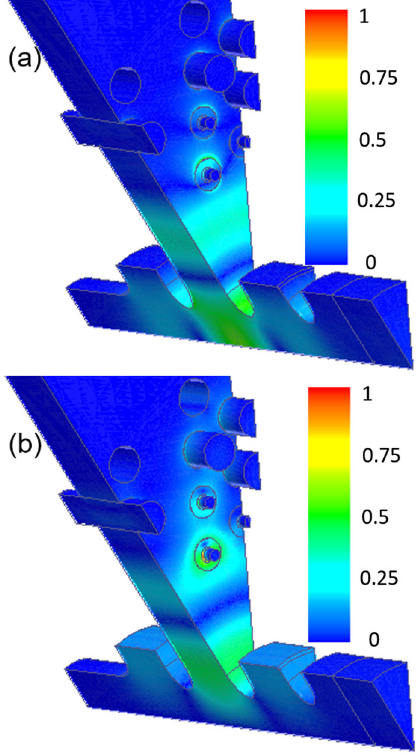
FIG. 14. The field distribution of (a) the surface electric field, and (b) the surface magnetic field of the HPBG-Pin structure in